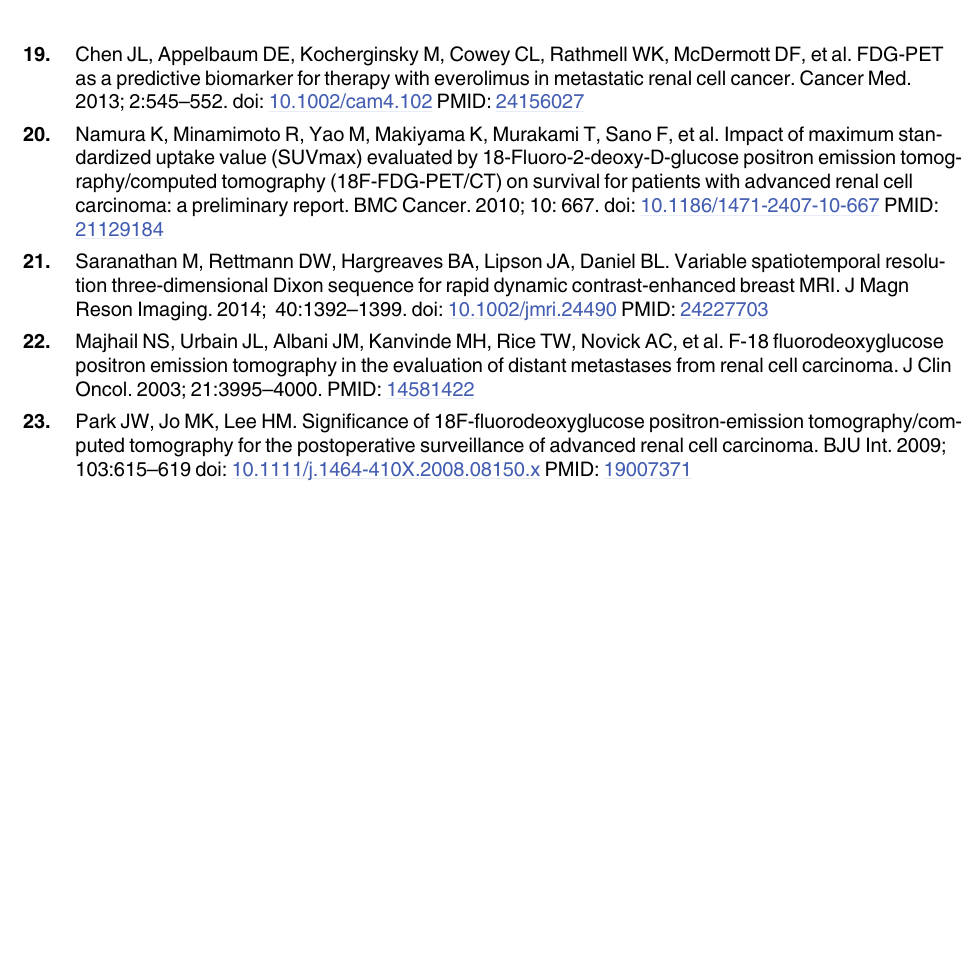
PLOS ONE | DOI:10.1371/journal.pone.0153321 April 28,